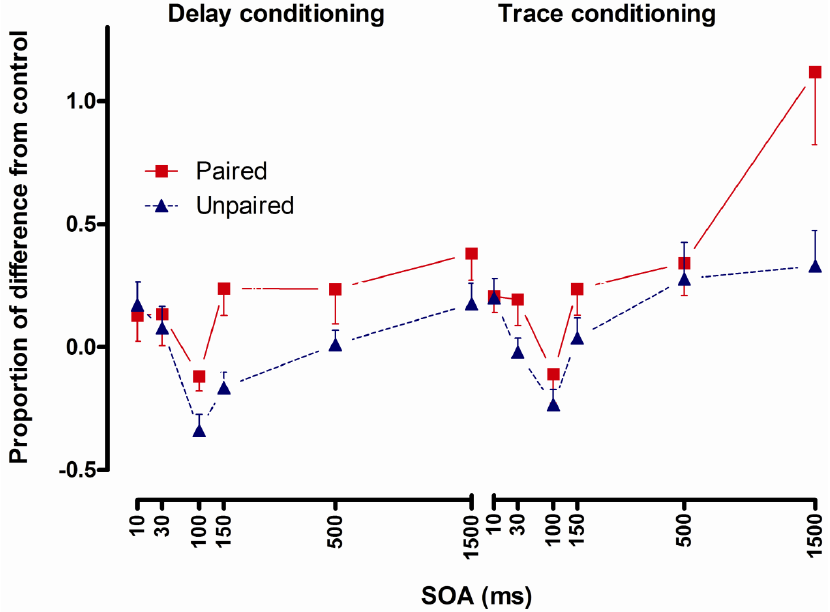
Figure 6. Startle reflexes following delay conditioning (left panel) and trace conditioning (right panel) expressed as proportion of difference from control in the paired and the unpaired group across stimulus onset asynchronies (SOA). Error bars represent 1 standard error of the